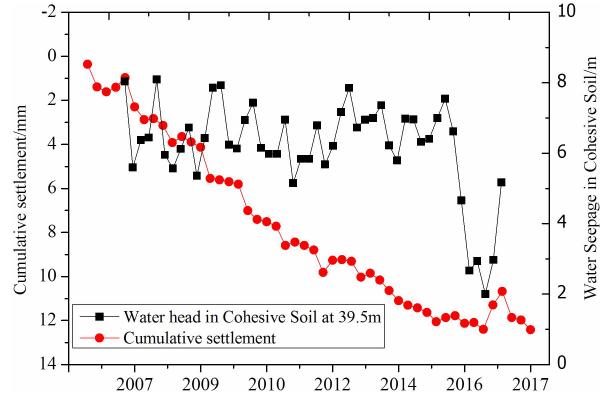
Figure 4. Comparison of accumulative settlement and pore head 39.5m change of step bench mark